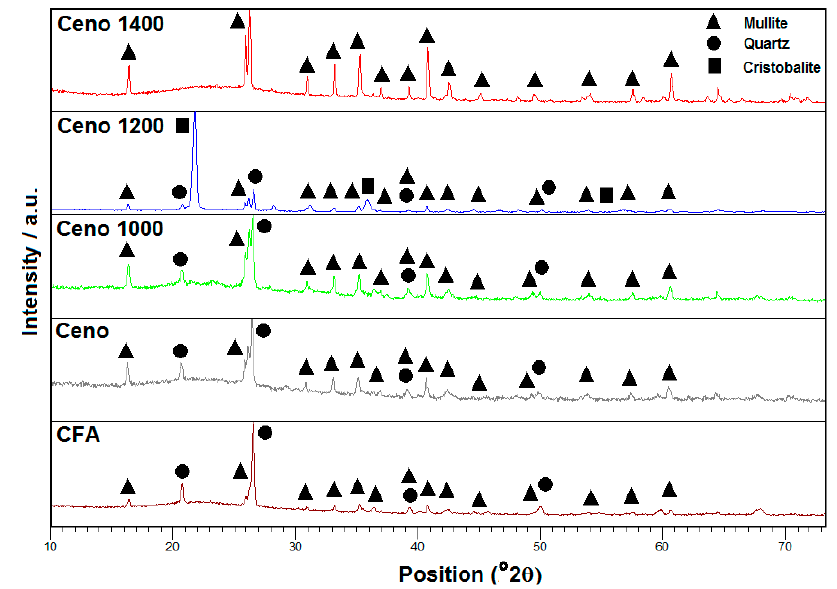
Figure 2. X-ray di ff ractogram of coal fly ash (CFA), cenospheres and cenospheres heated at 1000, 1200 Figure 2. X-ray diffractogram of coal fly ash (CFA), cenospheres and cenospheres heated at 1000, and 1400 ◦ C for 2 h. The broad hump appeared in the di ff ractogram at around 22.5 ◦ 2 θ was due to the 1200 and 1400 °C for 2 h. The broad hump appeared in the diffractogram at around 22.5° 2 θ was due amorphous glass content in the to the amorphous glass content in the sample. Table 2. Mineralogical phase composition of CFA and cenosphere samples.